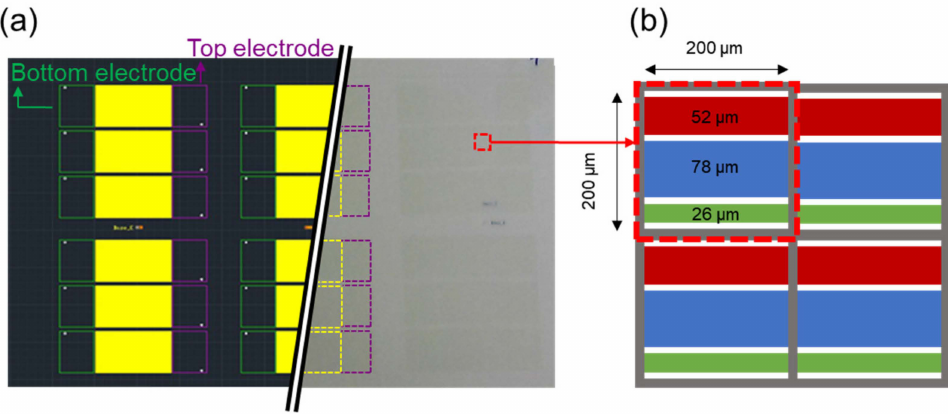
Figure 2. ( a ) The overall design, optical image, and ( b ) the cell design of E-paper with multiple electrode structures and its detailed